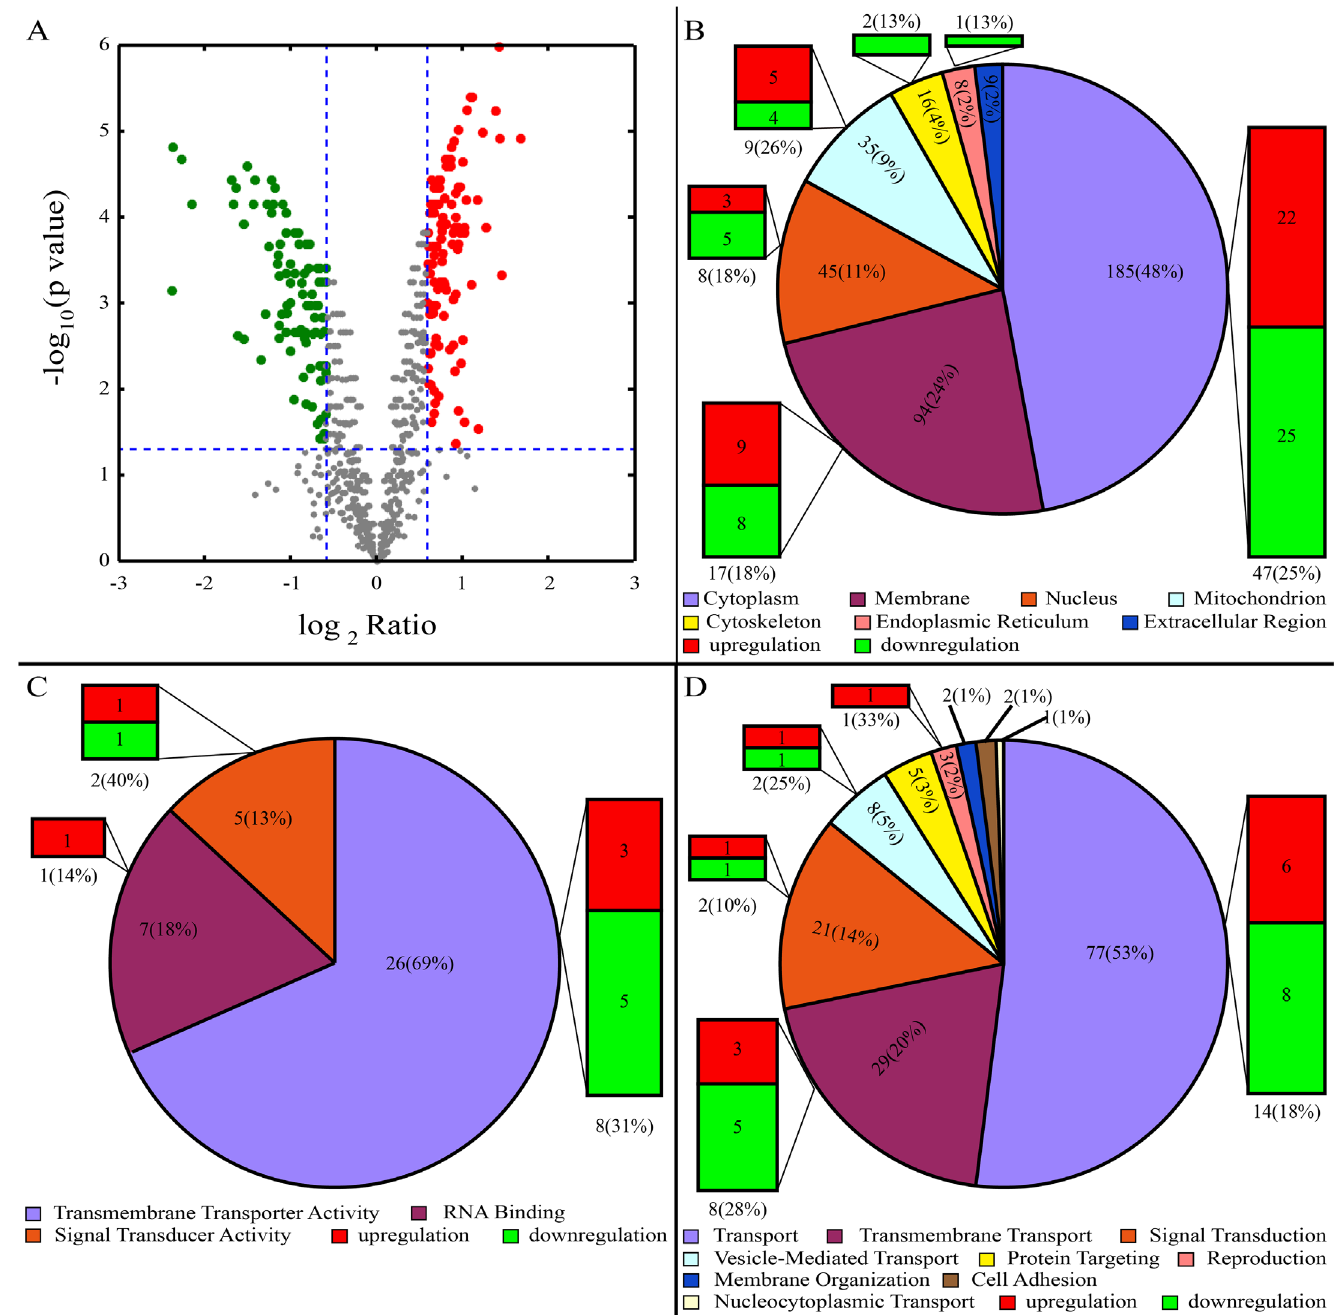
Fig 1. GO analysis of differential protein profile. (A) Volcano Plot of differential protein profile, The logarithmic ratios of the protein intensities were plotted against the negative logarithmic p-values of the t-test performed from triplicate experiments. Blue dotted lines separate specific differential proteins marked as red (upregulated) and/or green (downregulated) dots from the background (grey dots). (B) Predicted subcellular localization of proteins. (C) Predicted molecular functions classification of proteins. (D) Predicted biological process classification of proteins. Digit in pie chart indicated the quantity of total proteins and their percentage. Histogram showed the quantity of differential proteins and their percentage, red meant upregulation, downregulation in green.